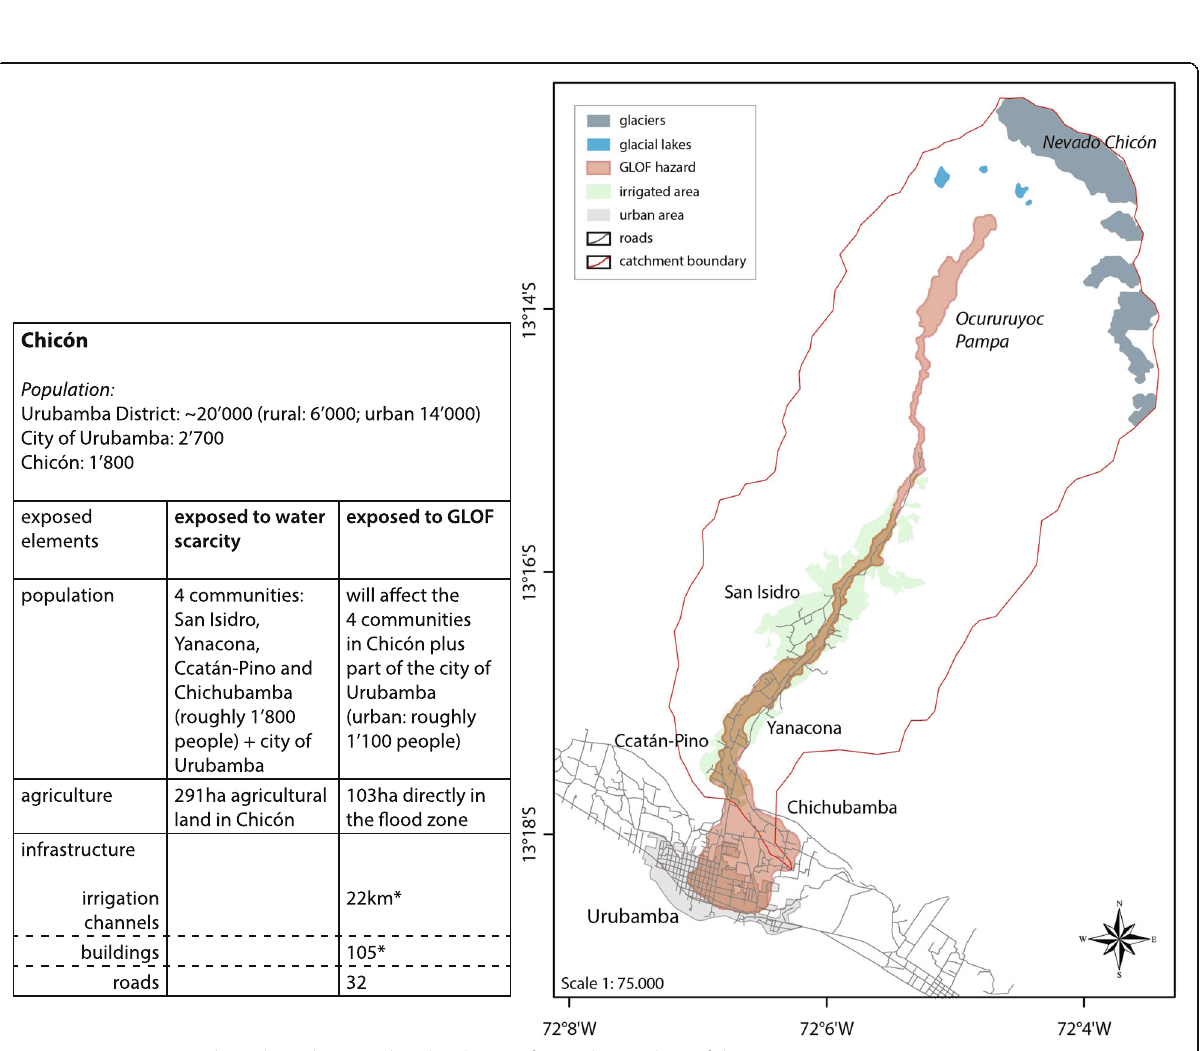
Fig. 6 Exposure to GLOF hazards in Chicón and Urubamba (*) refers to the numbers of the 2010 GLOF (INDECI